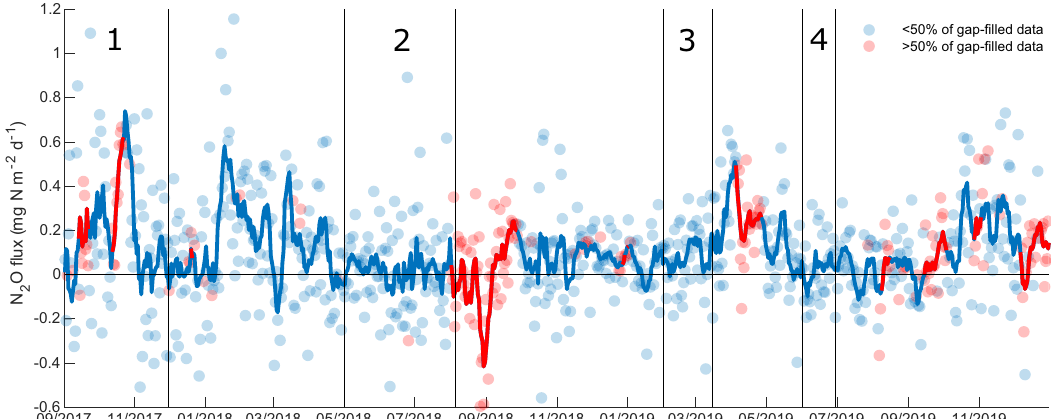
Fig. 4 Seasonal cycle of ecosystem N 2 O fl ux measured with quantum cascade laser absorption spectrometer in eddy tower. The markers denote daily total values, the line is a 7-day running mean. The periods marked with red color represent time intervals with gap- fi lled data (MDS-method) exceeding 50%. Hot moments: 1 — wet, 2 — drought (without showing drought onset), 3 — freeze-thaw, and 4 — dry-minor.